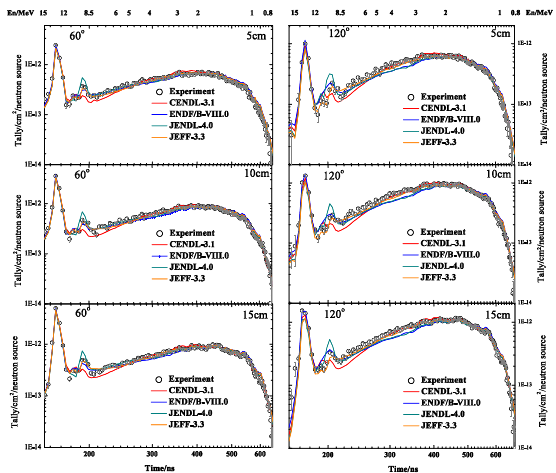
Fig.7 The comparison of measured and calculated leakage neutron spectra from iron sample （ Φ13 cm ） .